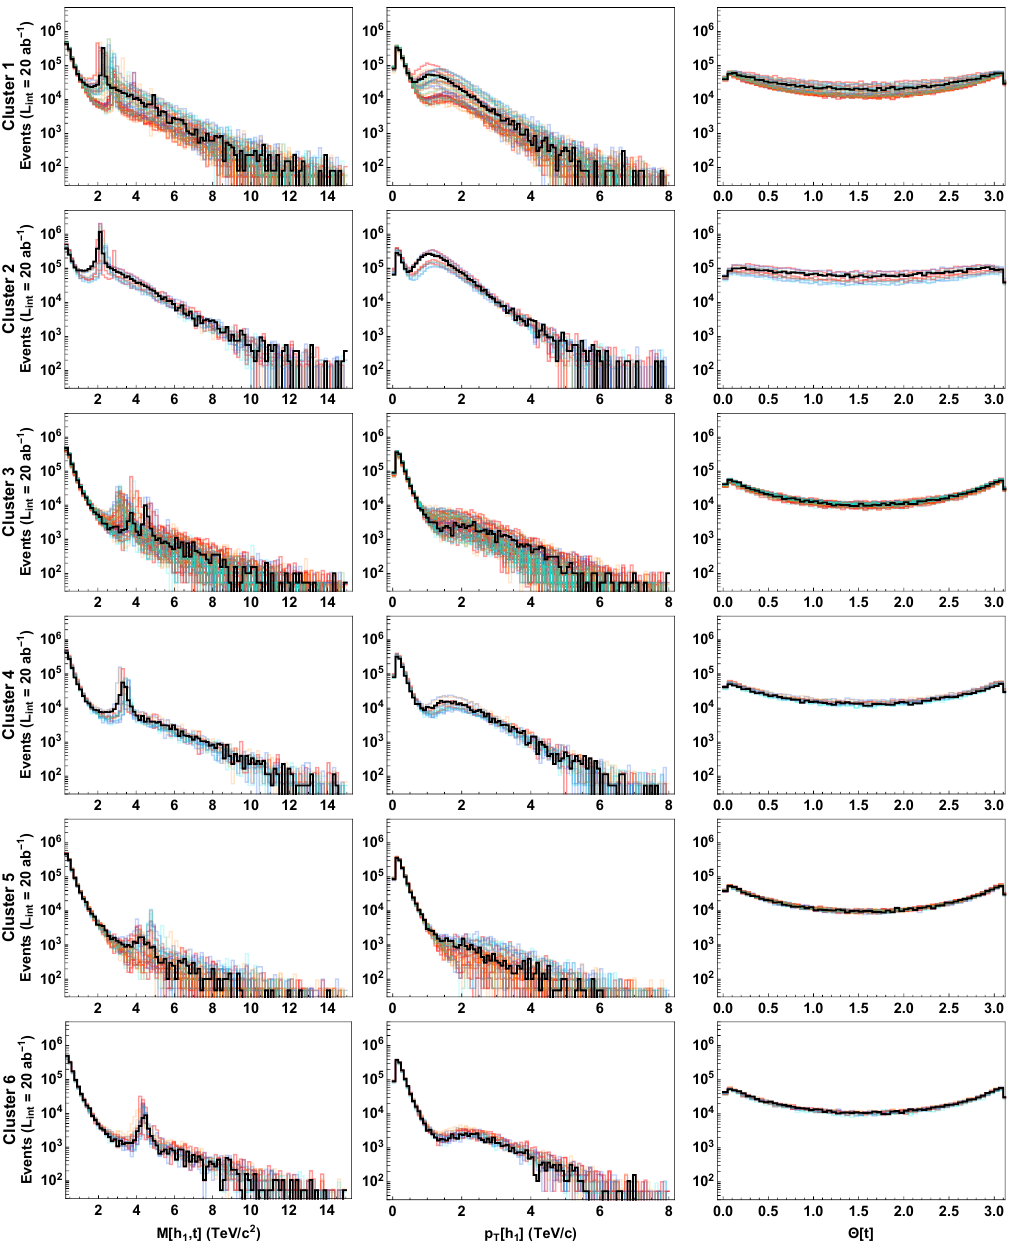
√ Figure 26 . Distributions at s = 100 TeV for the invariant mass of the pair composed by top and most energetic Higgs h 1 (first column), transverse momenta of h 1 (second column) and the top angle (third column), organized in clusters by similarity (clusters 1 through 6). Red, blue, orange and cyan curves indicate respectively points in Regions I, II, III and IV of the MCHM 14 . The benchmark point for each cluster is shown in black, with clusters 1 to 6 containing respectively points F 1 to F 6 in table 8 of the main